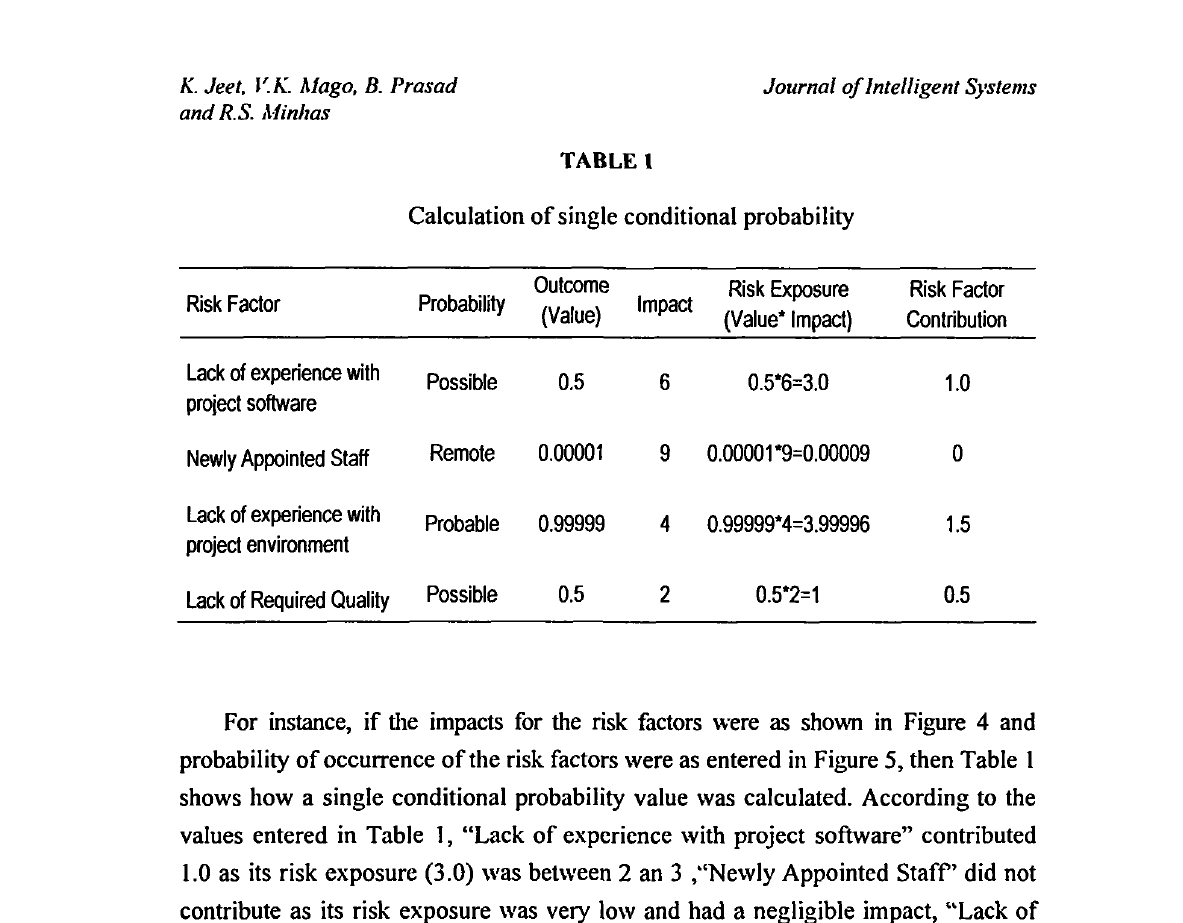
Calculation of single conditional